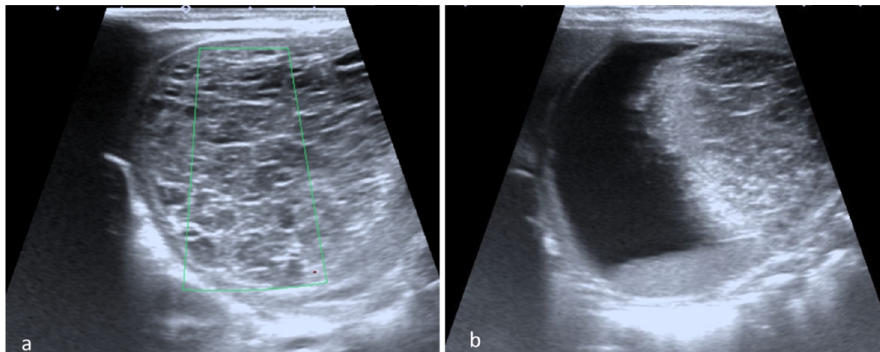
Figure 2. Ovarian torsion. ( a ) Postnatal abdominal ultrasound with enlarged, inhomogeneous structure without vascular Doppler signal; and ( b ) a cyst with fluid-fluid level .